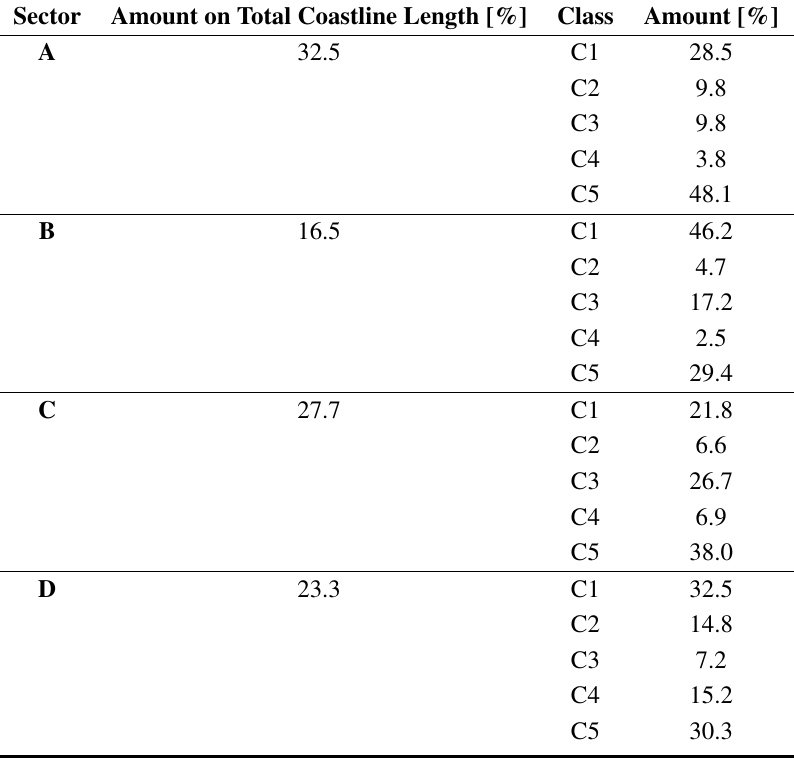
Table 2. Distribution of coastline classes (C1 = parallel surface structures, C2 = orthogonal surface structures, C3 = IS pattern, C4 = no crevasses, C5 = grounded ice) within four different sectors (see text). Sector Amount on Total Coastline Length